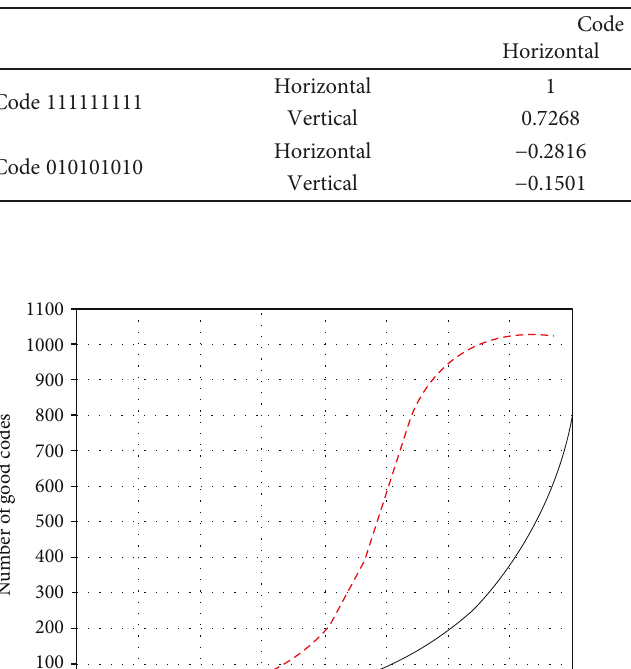
Table 2: The correlation coe ffi cient between the horizontal and vertical components of codes 111111111 and 010101010 after polarity correlator.